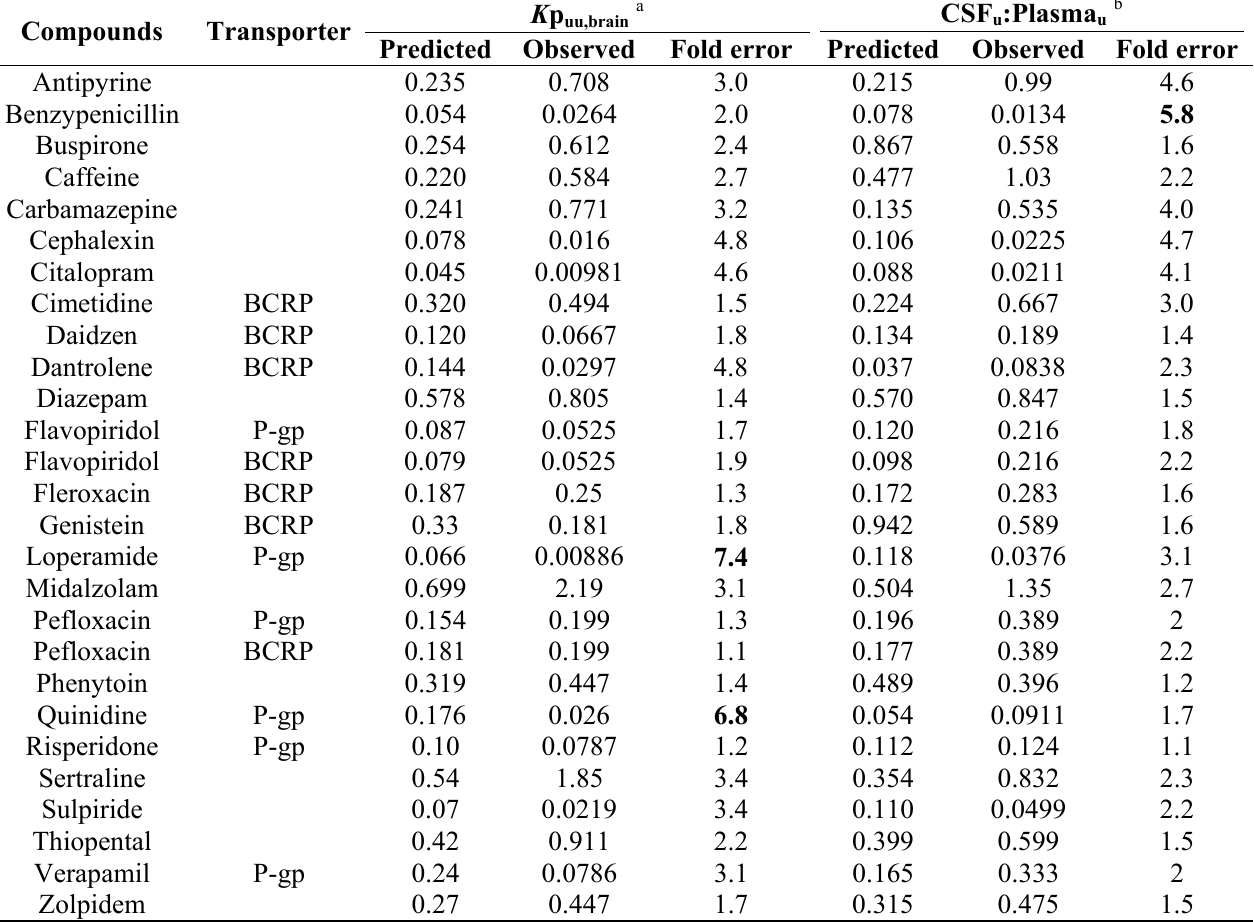
a,b Bold indicates parameters predicted with a fold-error